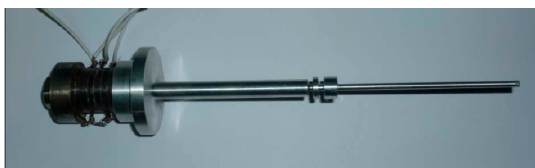
Figure 2. The drilling prototype.